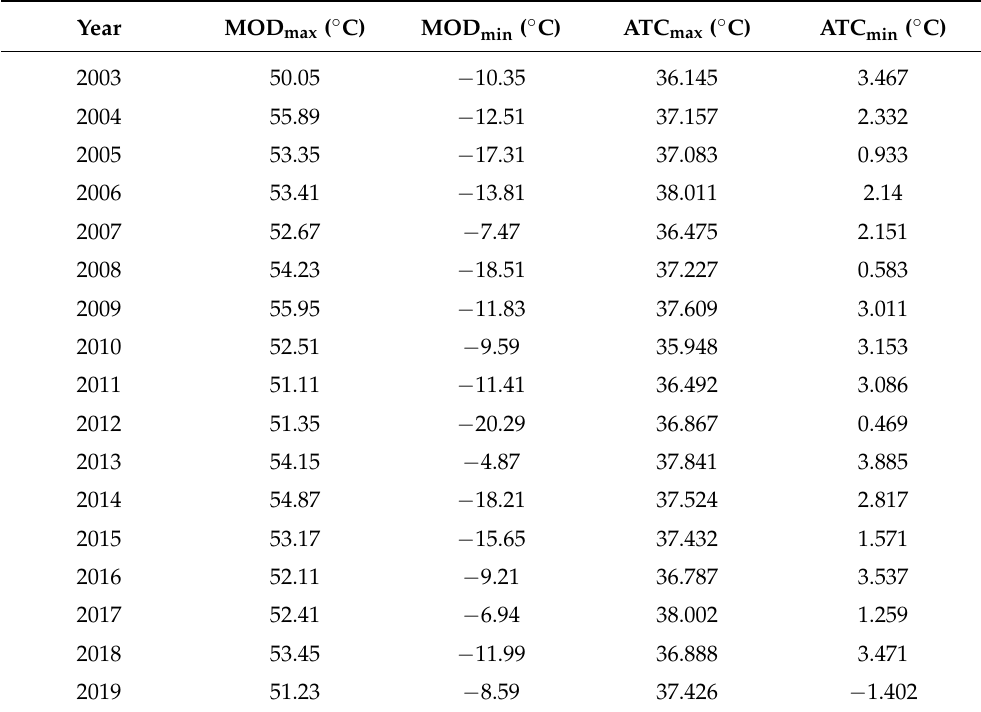
Table 7. Maximum and minimum annual average LST from 2003 to